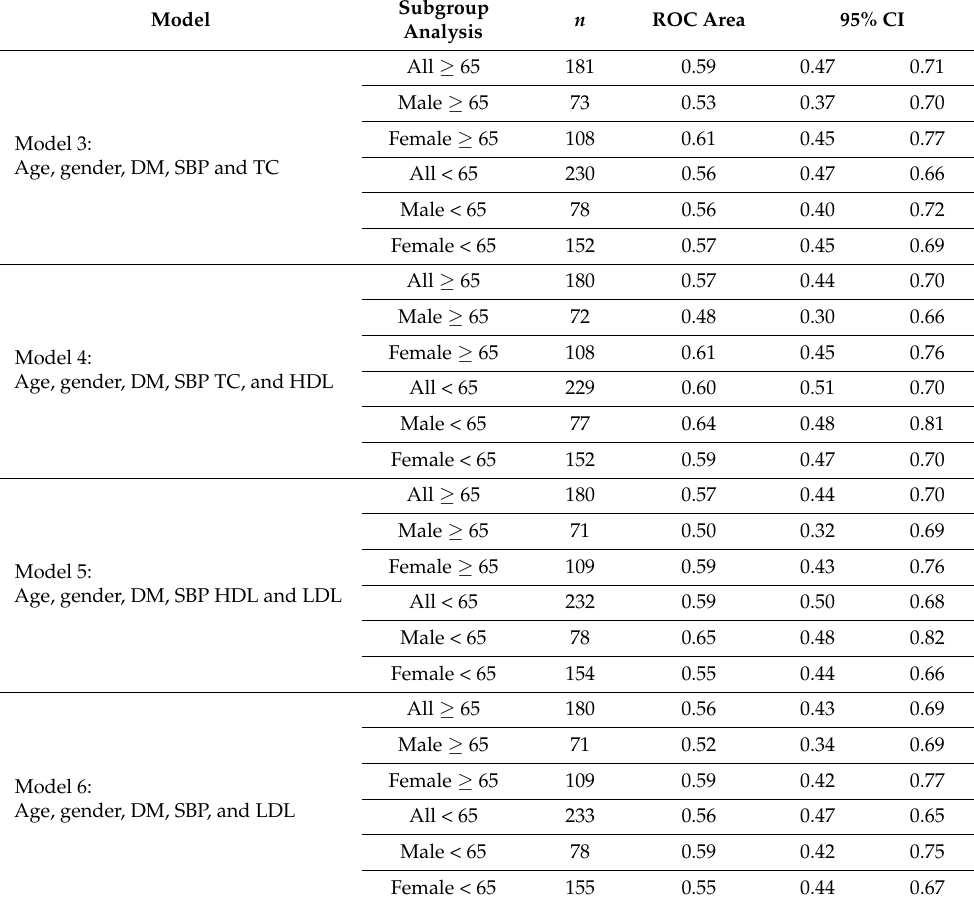
Table 4. Subgroup analysis of discriminative performance of laboratory-based